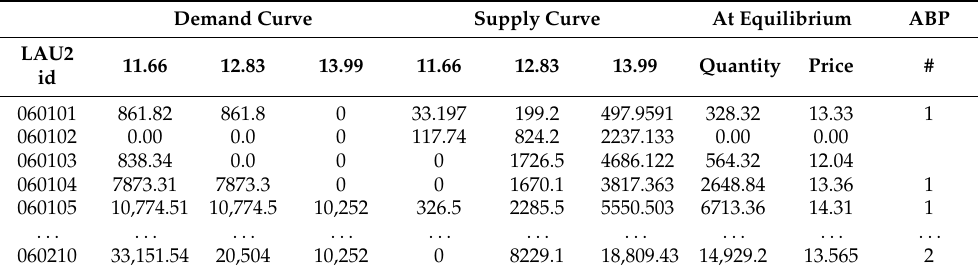
Table 6. Exemplifying integrated model output by each land unit with market clearing prices, quantities and ABPs selected.